Question: Provide a one-line summary of what is displayed.
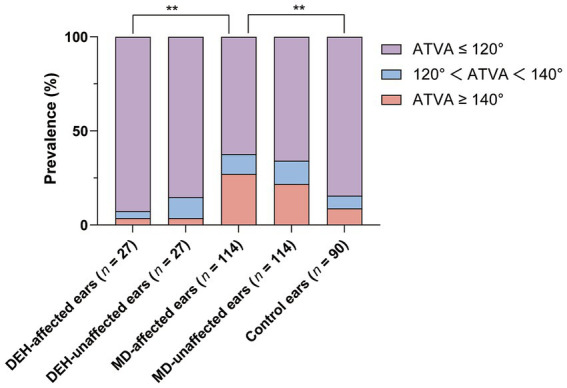
Answer: The distribution of the angular trajectory of the vestibular aqueduct (ATVA) categories in ipsilateral delayed endolymphatic hydrops (DEH) patients, unilateral Ménière’s disease (MD) patients and control participants. n = number of ears. **: p < 0.01.